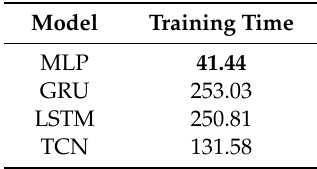
Table 3. Training time (in seconds) of di ff erent